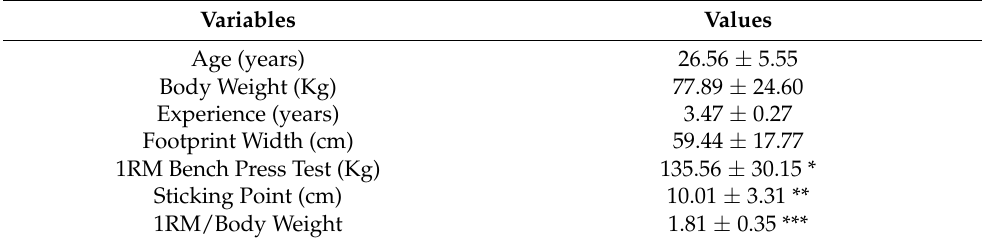
Table 1. Characterization of